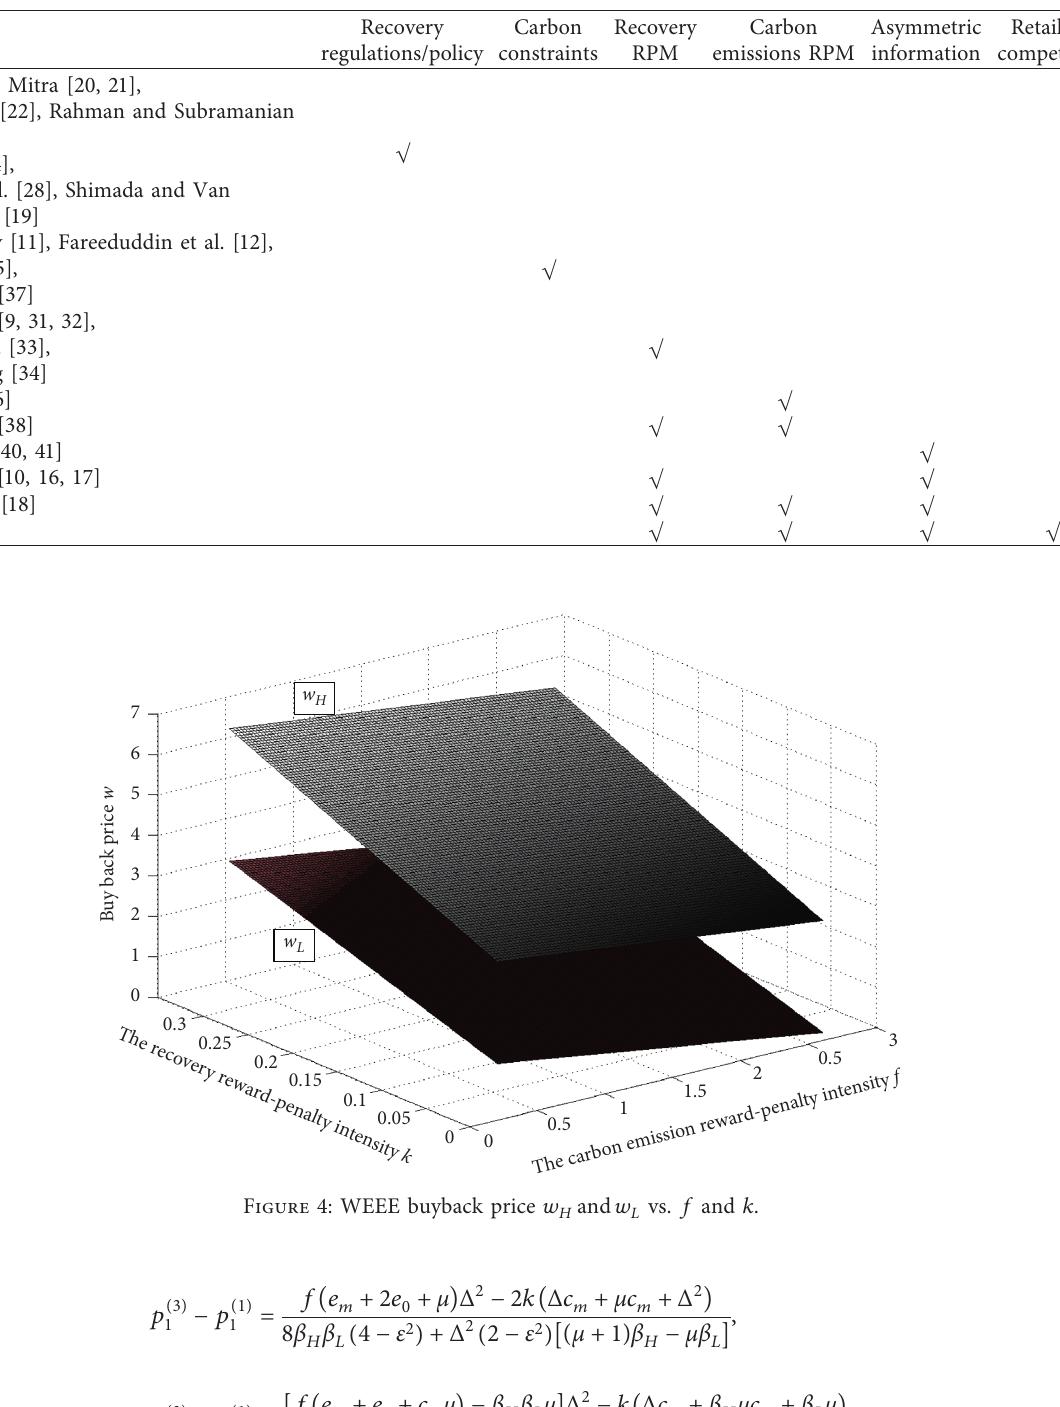
Table 1: The comparison of existing work with our paper.